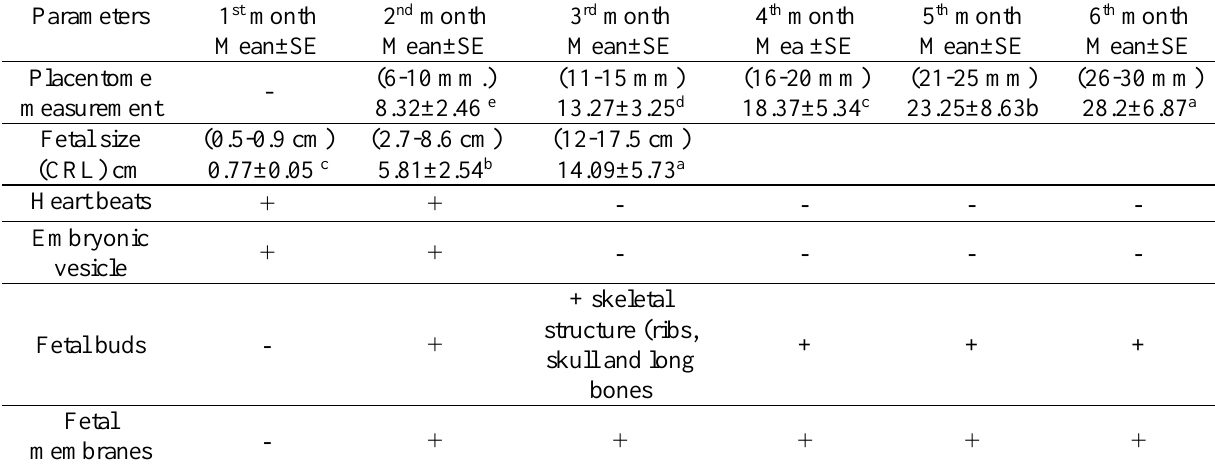
Table 2. Parameters determined by trans rectal transducer during 1st to six months of pregnancy in Iraqi